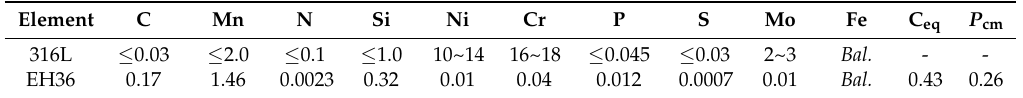
Table 2. Laser beam processing parameters.